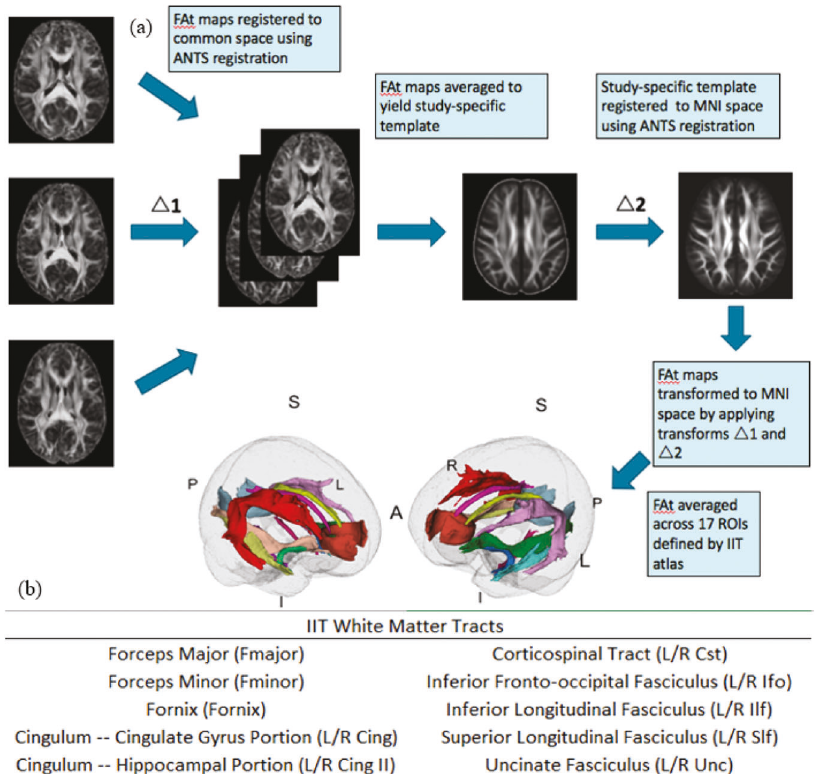
Fig. 1 DMRI Processing Pipeline. a Registration of longitudinal FAt maps to IIT atlas and extraction of FAt; b List of utilized WM tracts as de fi ned by IIT atlas (note L/R stand for left and right-hemispheric portions,